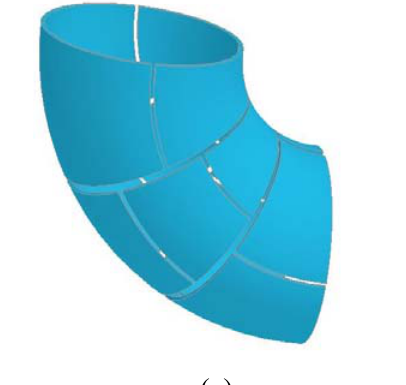
Figure 7. Configurations of ECVT sensors: (a) smooth right-angle bend; (b) sharp right-angle bend; (c) T-shape vessel; (d) half-cylindrical